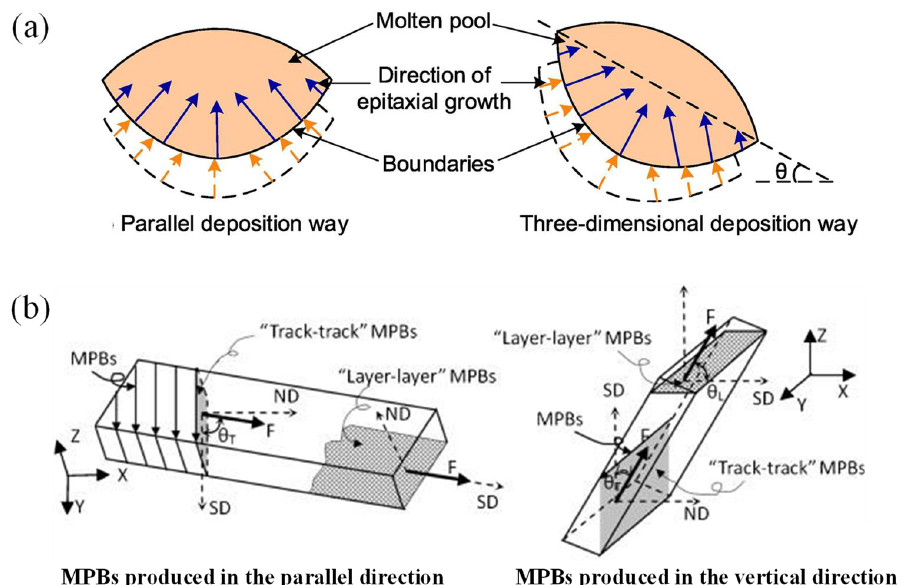
Figure 8. ( a ) Schematic of direction of grain growth in different deposition way (Reprinted from ref. [26], copyright (2020), with permission from Elsevier); ( b ) The force analysis diagram of molten pool boundaries produced in horizontal and vertical direction (Reprinted from ref. [13], copyright (2014), with permission from Elsevier).